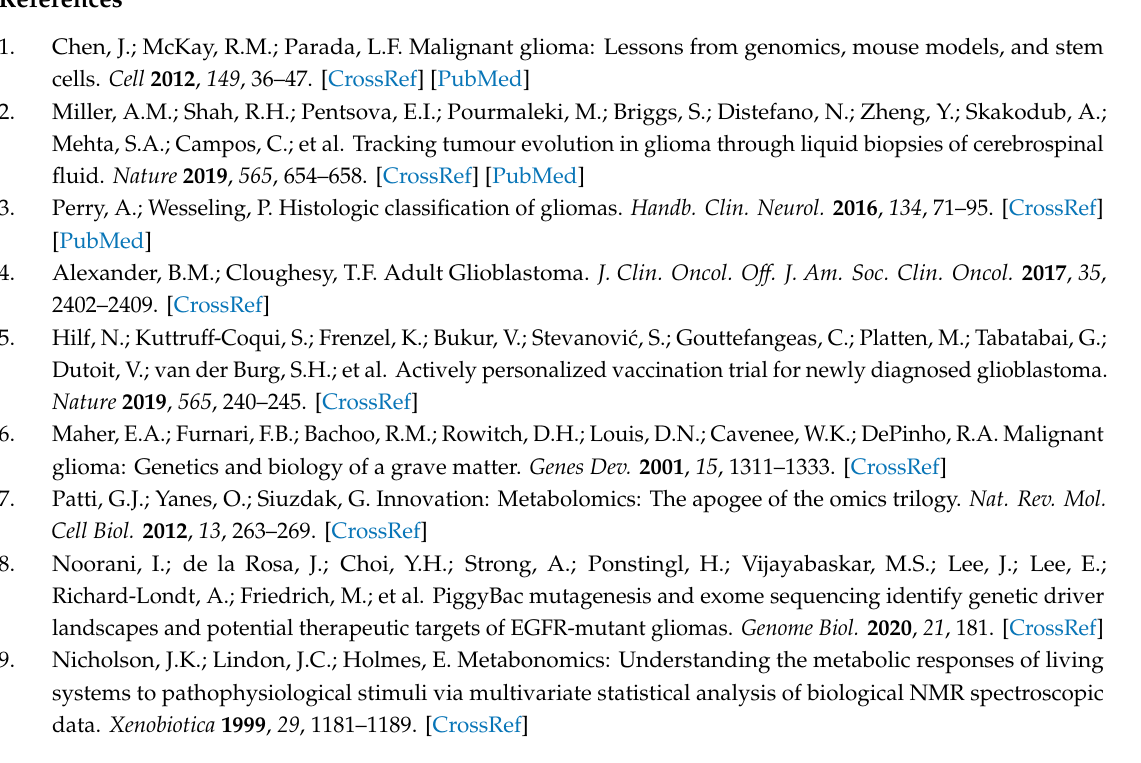
Figure S1: The compound classifications of 668 metabolites identified in gliomas and para-tumor tissues, Figure S2: The context of acylcarnitines in di ff erent grades of glioma tissues, Figure S3: Fatty acid degradation pathway in KEGG, Figure S4: The gene expression of ACADS in di ff erent grades of glioma tissues, Table S1: The chromatogram-mass spectrometry information of 668 identified